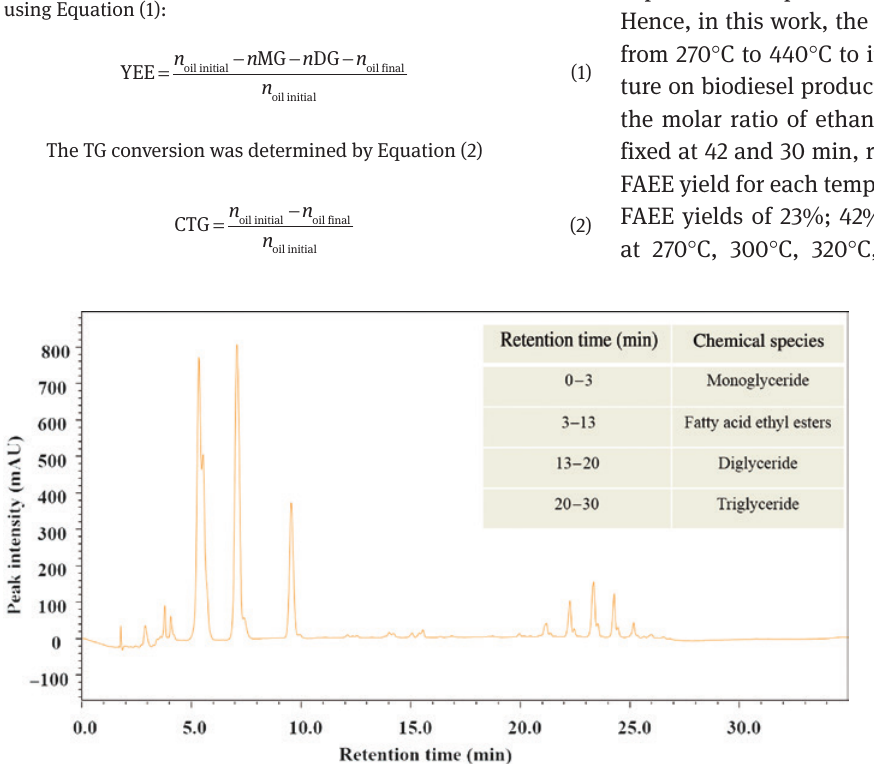
Figure 2: HPLC chromatogram of biodiesel sample from rapeseed oil and